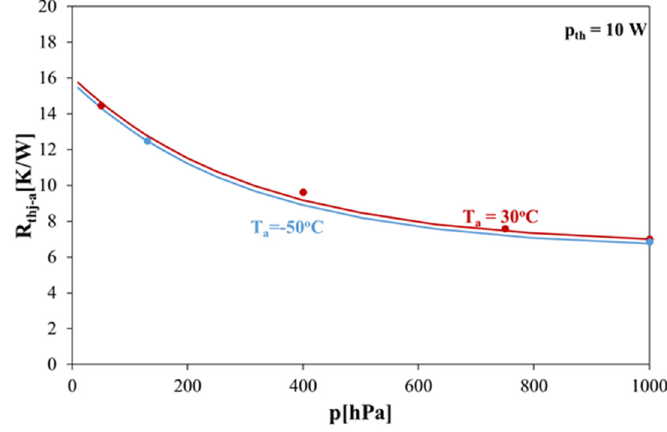
Figure 7. Measured and computed dependences of thermal resistance of the tested diode on atmos- pheric pressure for two values of ambient temperature.